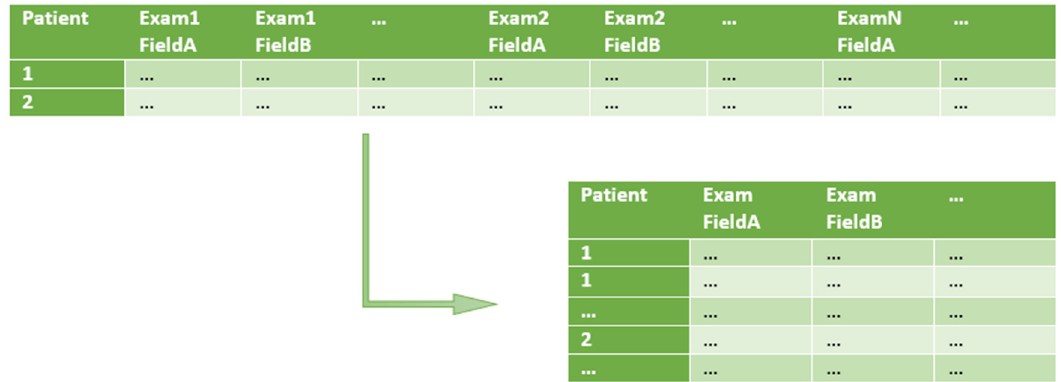
Figure 5. 1:m row split example.